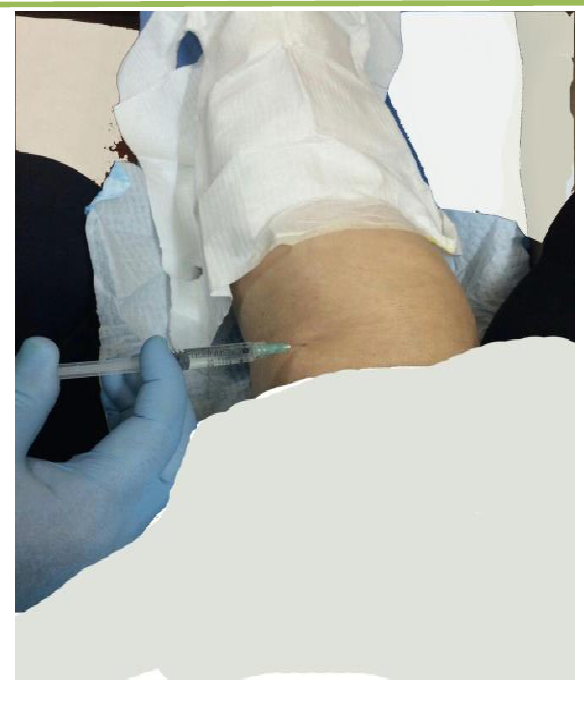
Figure 12.And that for physical function